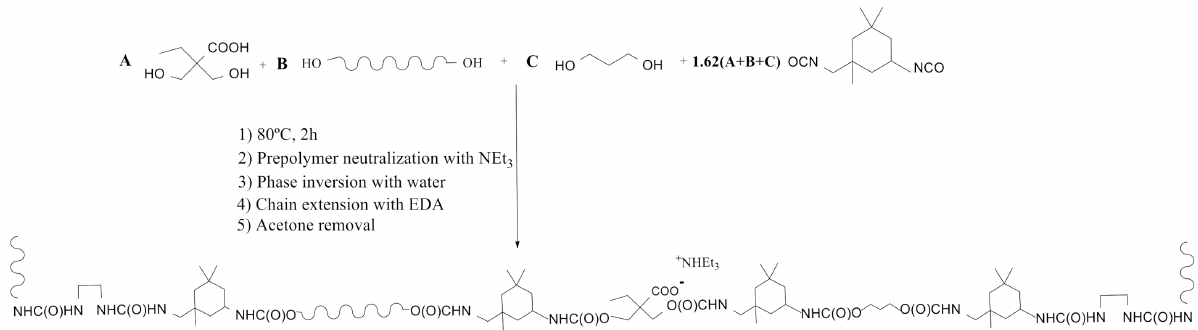
Figure 4. Synthesis scheme of the waterborne polyurethane-urea